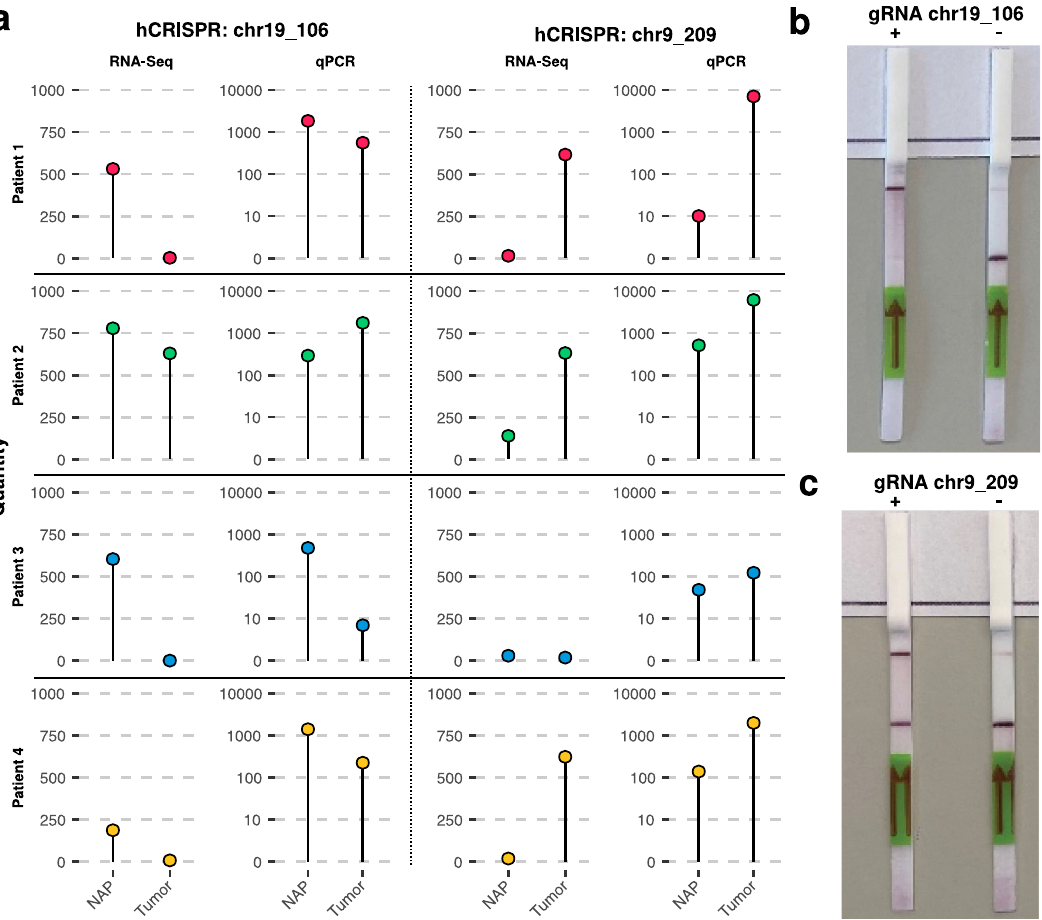
Fig. 7 RT-qPCR validation of hCRISPR expression in normal prostate tissue and tumor samples from four prostate cancer patients and detection by SHERLOCK and DETECTR. a Expression of hCRISPR chr19_106 and chr9_209. Left panels show the normalized number of sequencing reads mapping to hCRISPR chr19_106 and chr9_209 in the NGS-ProToCoL RNA-Seq dataset. Right panels show the normalized transcript copy number of hCRISPR chr19_106 and chr9_209 measured by RT-qPCR in the same samples. NAP is normal adjacent to tumor prostate tissue. Tumor, prostate tumor tissue. b Photograph of the DETECTR technology identifying the presence of hCRISPR chr19_106. ( + ) indicates a positive and ( − ) indicates a negative detection result. c Similar to b but for the presence of hCRISPR